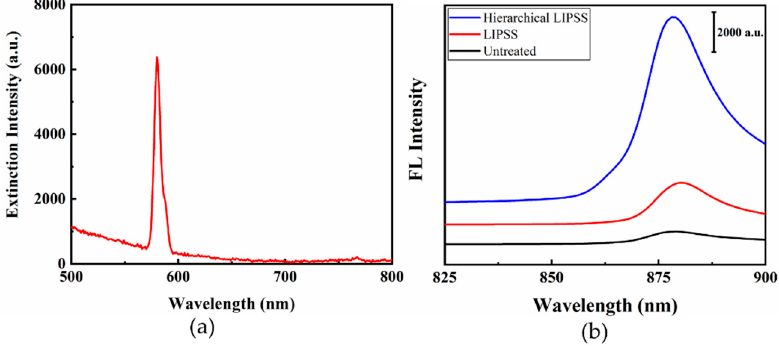
Figure 7. ( a ) Fluorescence extinction spectra of CV; ( b ) Fluorescence spectra of CV on the untreated, LIPSS, and hierarchical LIPSS, with excitation wavelength at 580 nm.